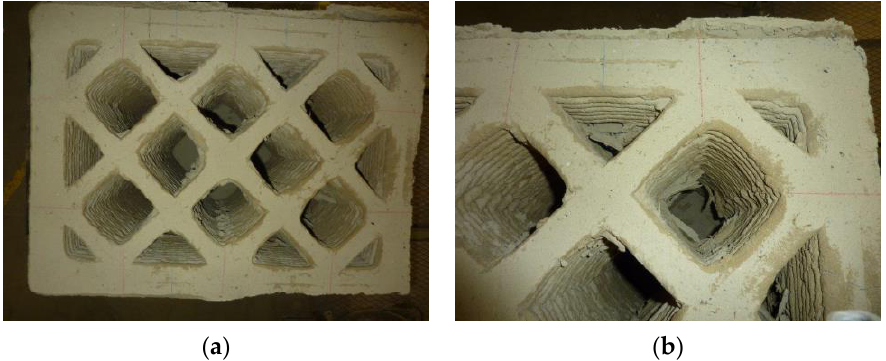
Figure 25. Top view of the specimen after the test: ( a ) overall view and ( b ) detail of the corner at the top right.